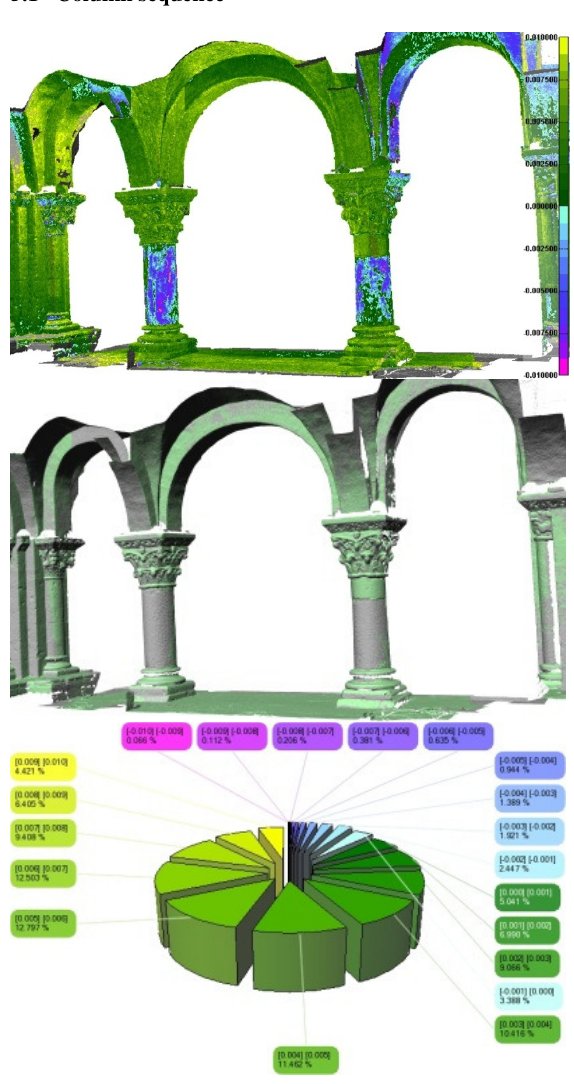
Figure 5. Error-map color mode, per scanner color mode and pie-type error distribution chart for subproject